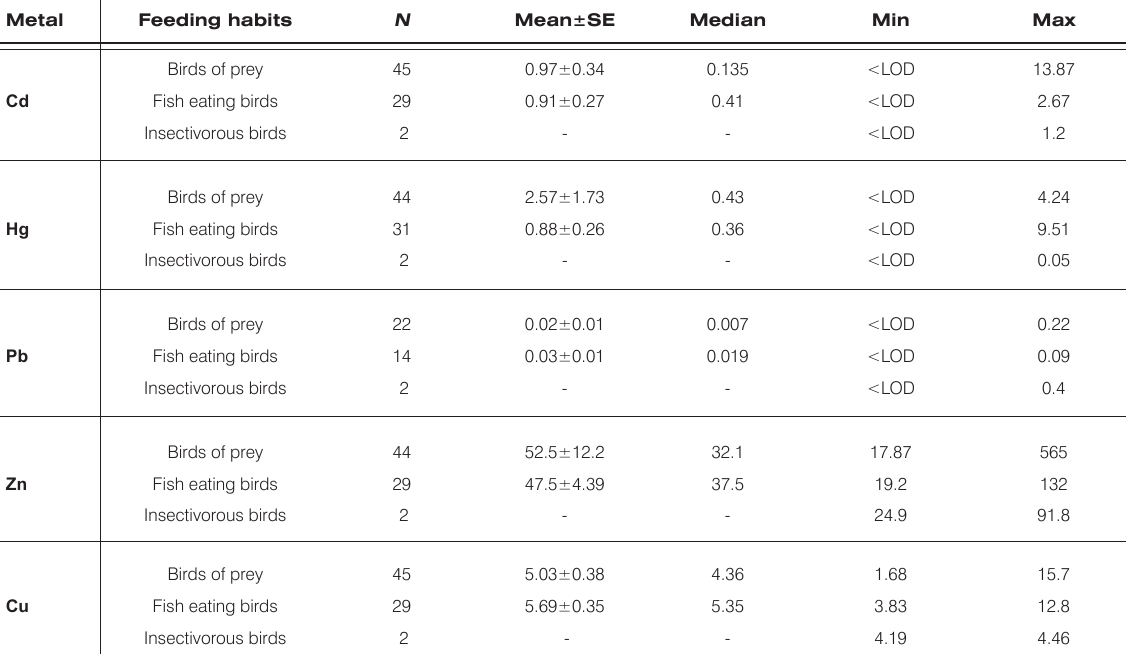
Table 3. Metal concentrations in kidney; values are expressed in µg g -1 wet weight Metal Feeding